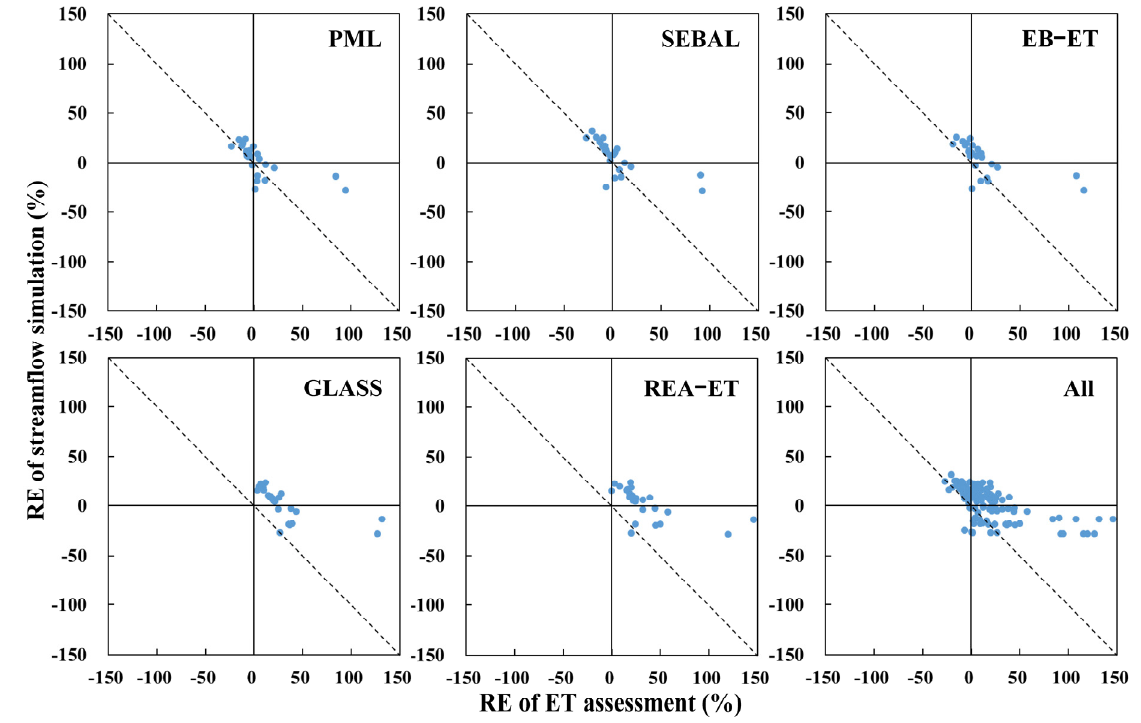
Figure 12. Scatter plots of the RE of ET datasets assessment and the RE of multi-year streamflow evaluations at the sub-basin scale.